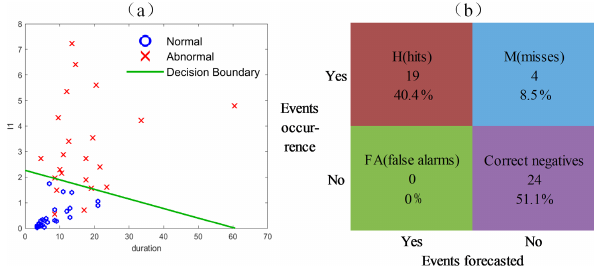
Figure 2. The schematic diagram (a) and contingency table (b) of the binary classifier for